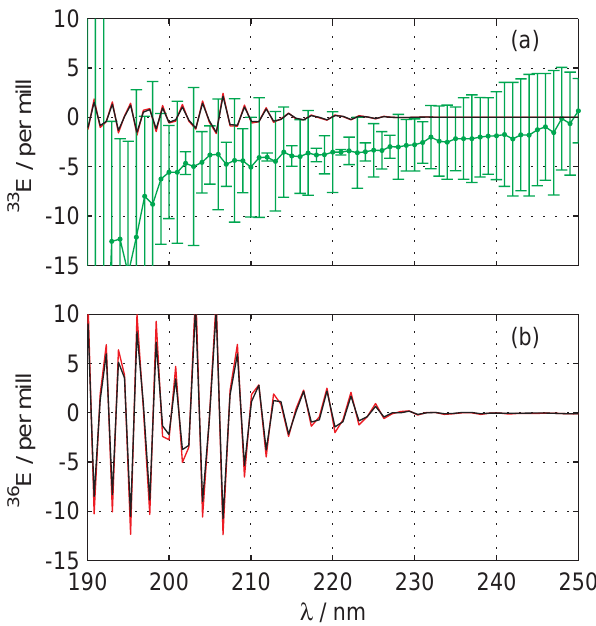
Fig. 3. (a) The calculated 33 E vs. wavelength at 295K (black) and 220K (red) compared to the experimental results at room temper- ature (green) by Hattori et al. (2011). (b) The calculated 36 E vs. wavelength at 295K (black) and 220K (red).